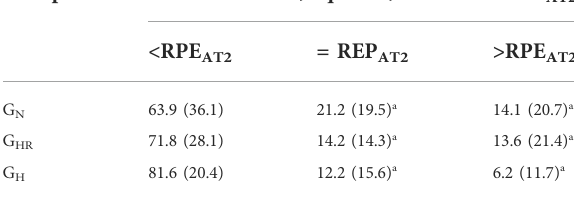
TABLE4Comparisonofthesetpercentagebelow,equalto,andabove the heart rate relative to the anaerobic threshold 2 (HR AT2 ) over the 8 weeks of intervention. Group % Of sets below, equal to, and above RPE AT2 <RPE = REP >RPE AT2 AT2 AT2